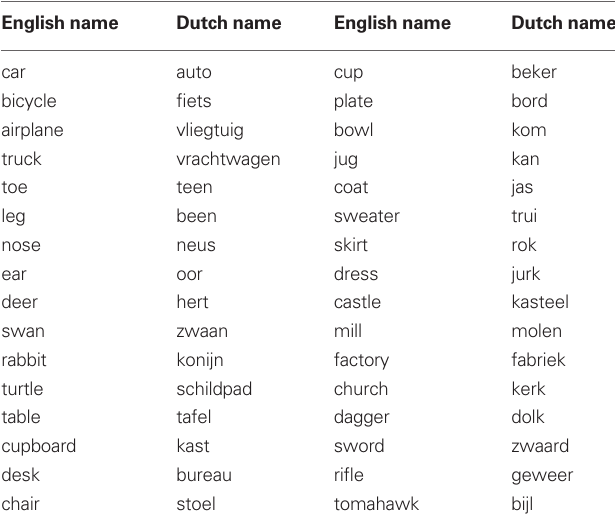
Table 1 | Basic-level names of the pictures in english (the target language) and their Dutch translation